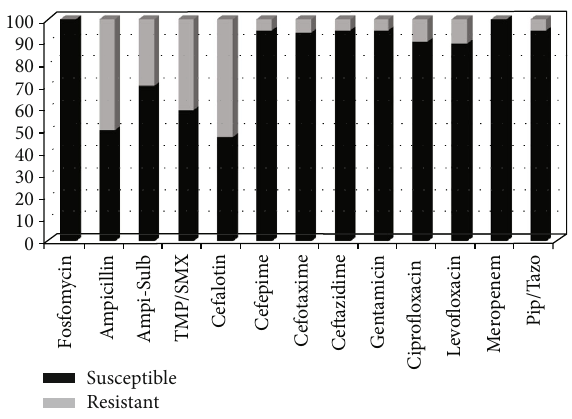
Figure 2: Percentage of E. coli isolates susceptible to antimicrobial drug. TMP/SMX: trimethoprim/sulfamethoxazole; Ampi-Sulb: ampicillin-sulbactam; Pip/Tazo: piperacillin-tazobactam.